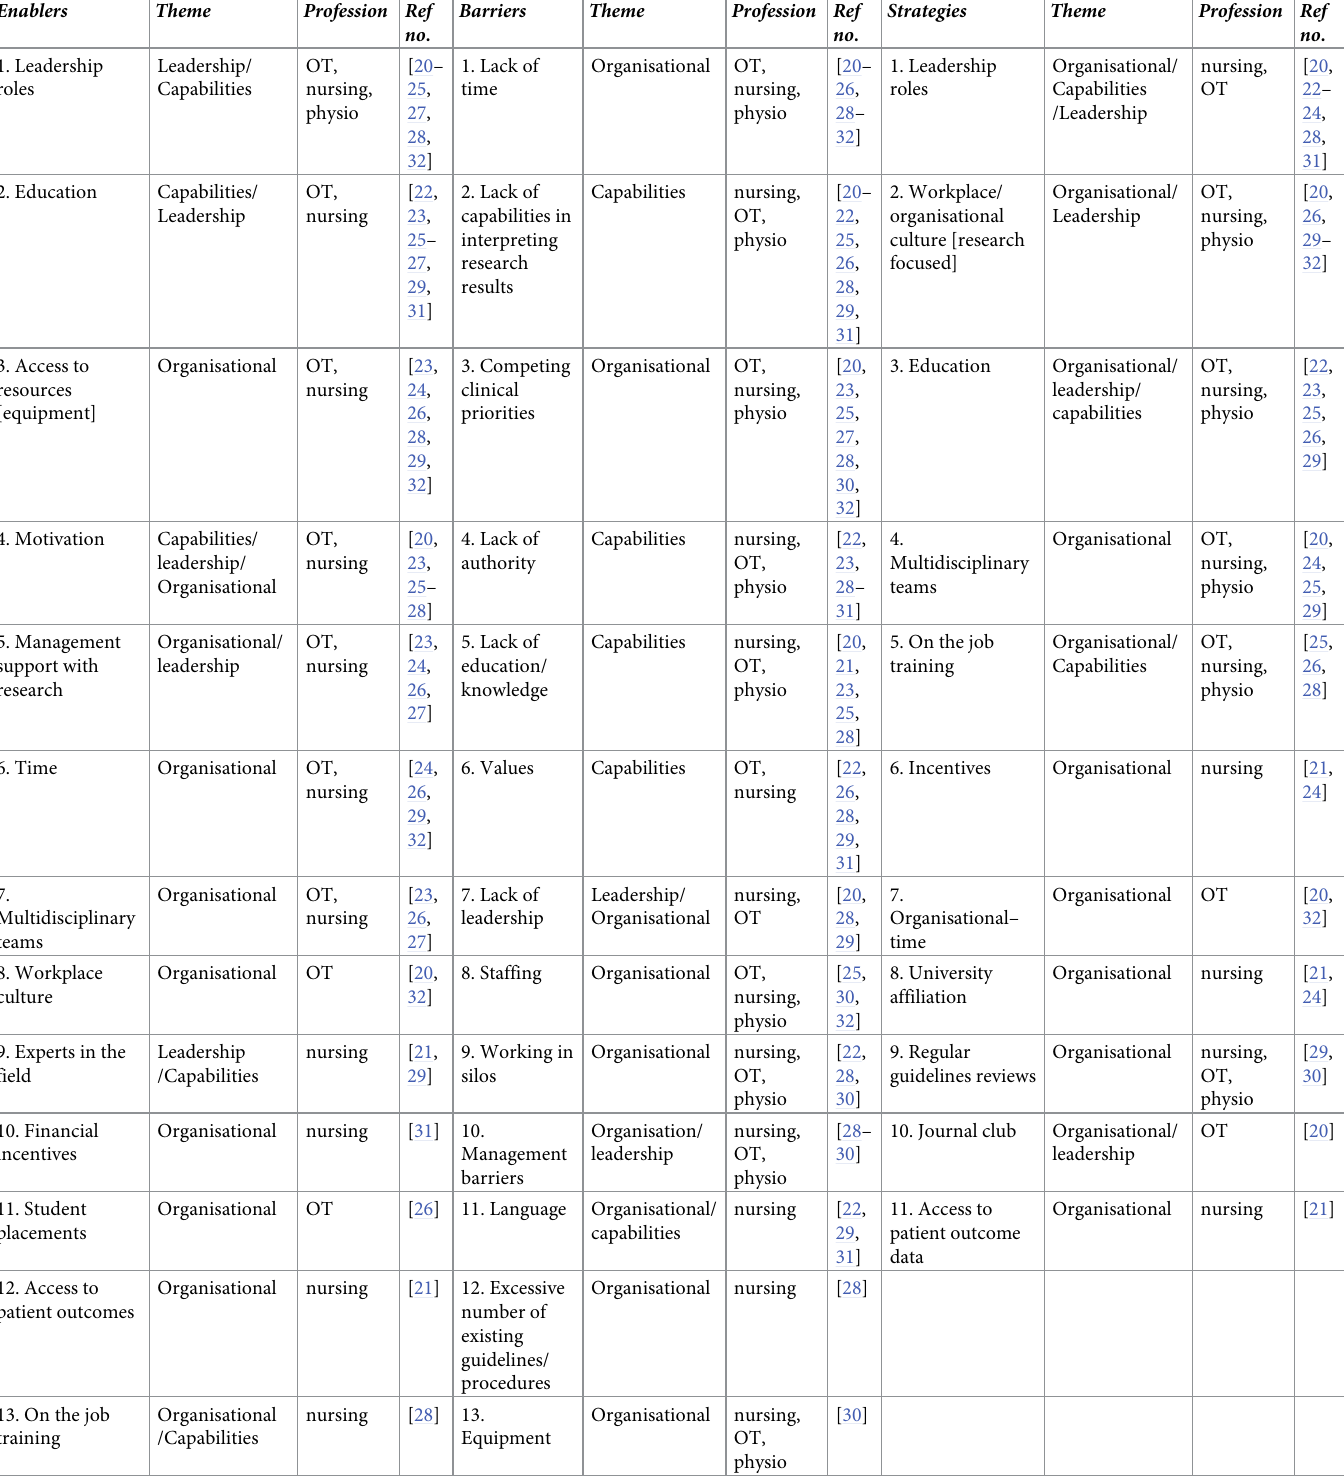
Table 3. The key barriers, enablers, strategies and overarching themes identified in the included studies.